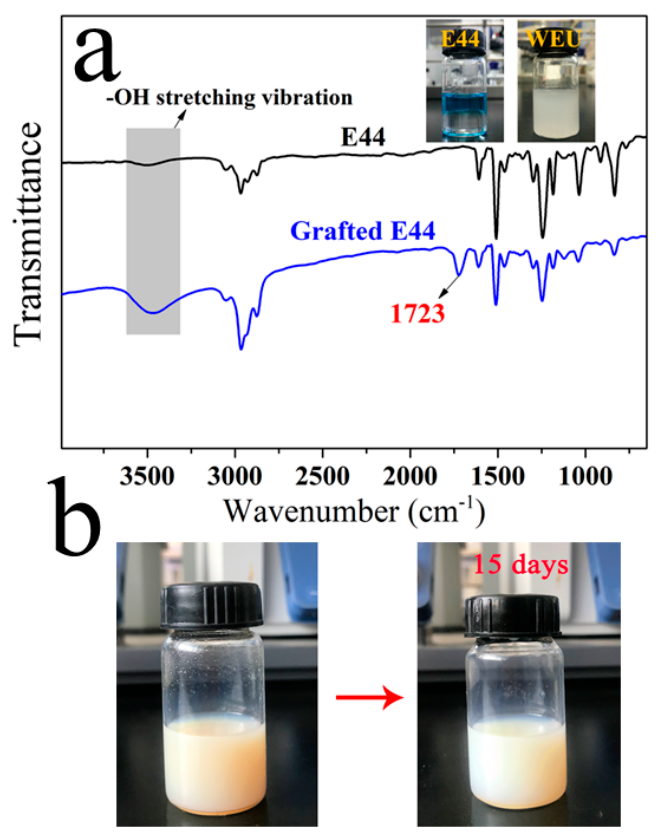
Figure 1. The FTIR spectrum of pure E44, grafted E44. Inset digital photograph of E44 respectively dispersed in water and WEU ( a ), and the stability of WEU after being stored for 15 days ( b ).